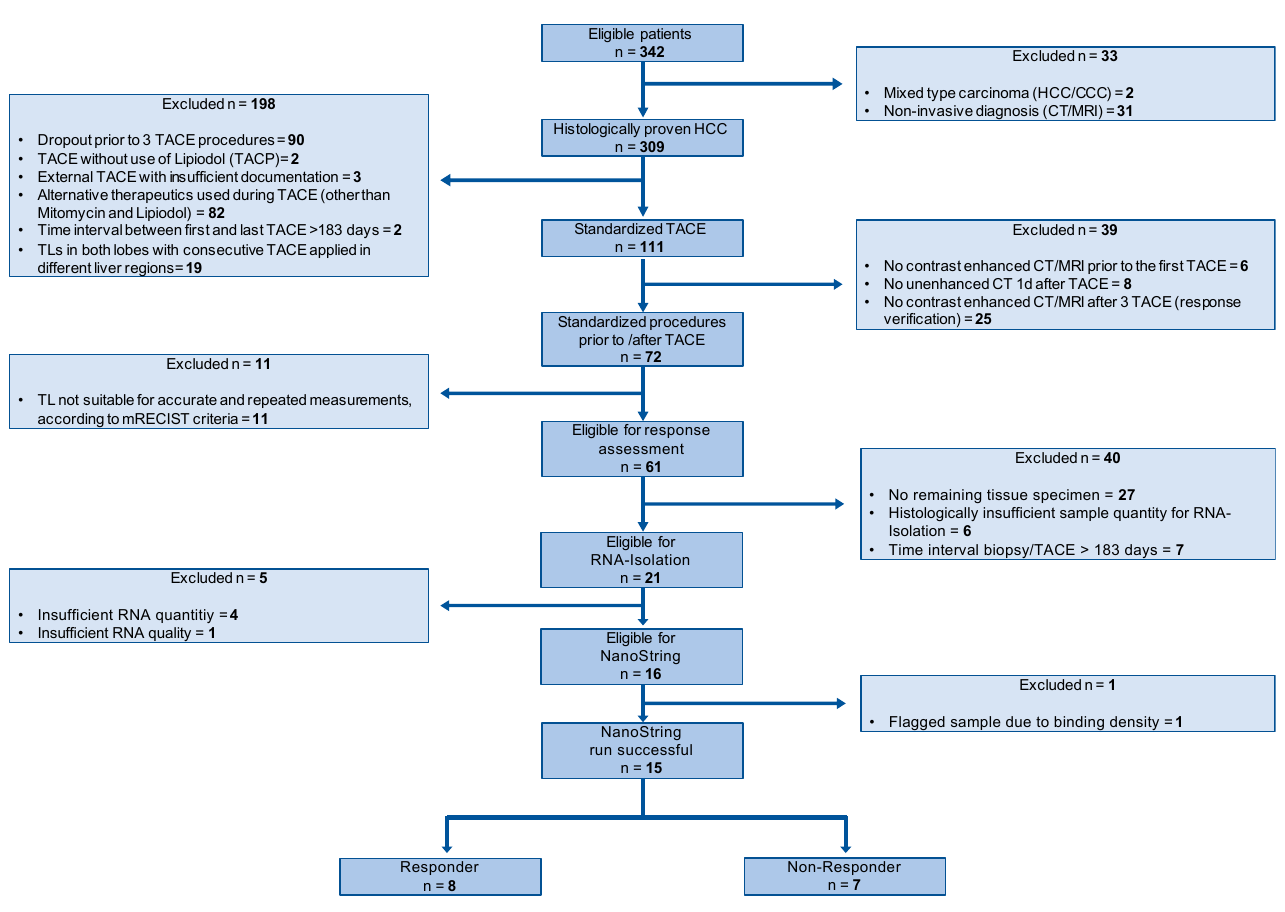
Figure 1. STARD fl owchart of patient inclusion into the study. Abbreviations: standards for Figure 1. STARD flowchart of patient inclusion into the study. Abbreviations: standards for reporting reporting diagnostic accuracy studies (STARD). diagnostic accuracy studies Table 1. Clinical and epidemiological characteristics.